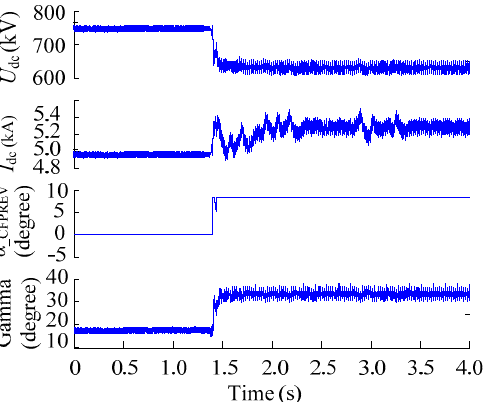
Figure 13. Reproduction of the disturbance due to the transformer excitation current recorded at GuanDu substation and the proposed commutation failure prediction algorithm.